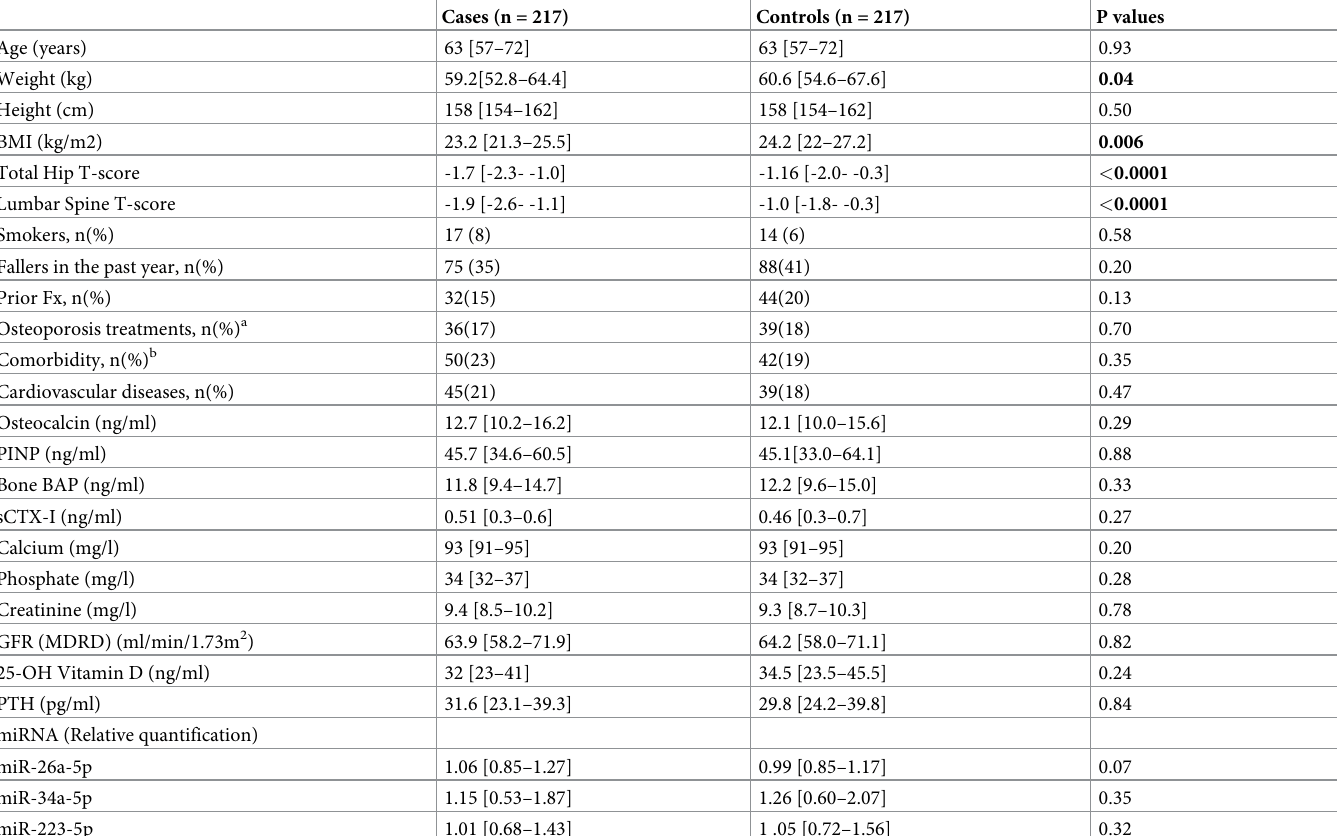
Table 3. Baseline demographic and biological characteristics of cases (with incident fracture) versus controls (without incident fracture), and miRNA quantifica- tion (median [interval